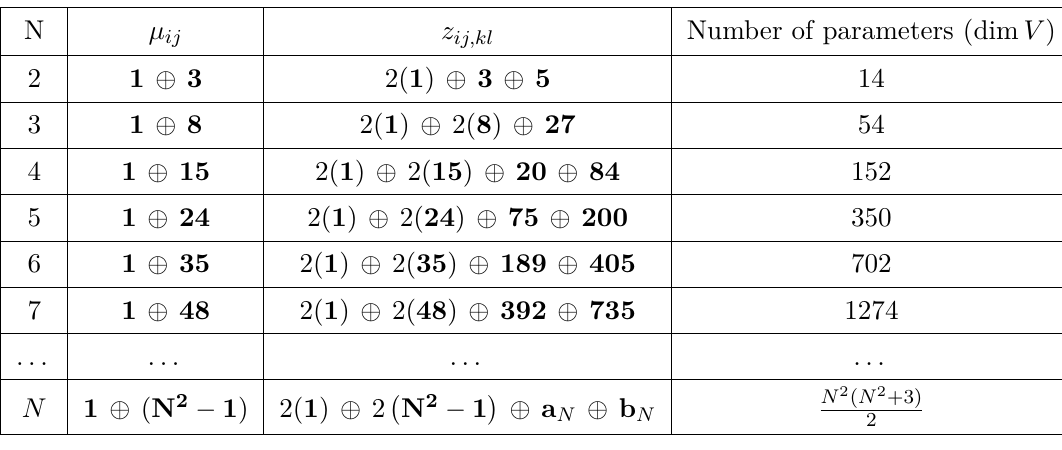
Table 2 . Representation decomposition of the NHDM where a N and b N are given in eq.